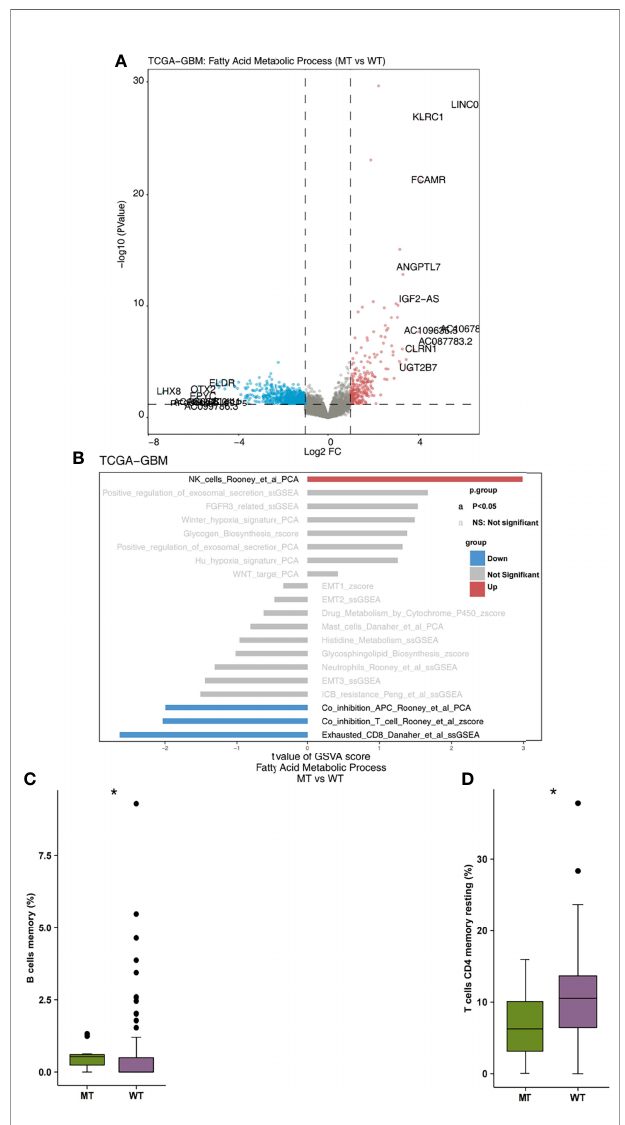
FIGURE 3 | (A) The volcano plot of the differentially expressed genes in the TCGA-GBM queues. The red dot represents the signi fi cantly up-regulated genes (P < 0.05; log2FC > 1), while the blue dot represents the signi fi cantly down-regulated genes (P < 0.05; log2FC < -1). (B) The bar plot representing the up-regulated and down-regulated immune cells scores estimated by the ssGSEA method. The red bar represents the signi fi cantly up-regulated immune cells in the fatty acid metabolic process of the MT group, while the blue bar represents the signi fi cantly down-regulated immune cells in the fatty acid metabolic process of the MT group. The grey bar represents that there are no signi fi cantly different immune cells or pathways. (C) A comparison of the scores of the memory B cells and the fatty acid metabolic process of the MT and WT groups. (D) A comparison of the scores of the resting memory CD4+ T cells CD4 and the fatty acid metabolic processes of the MT and WT groups. MT, mutant-type; WT, wild-type; ssGSEA, Single sample Gene Set Enrichment analysis. *P <